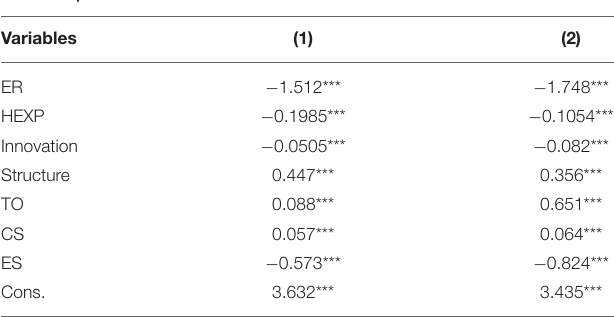
TABLE 7 | Robust results OLS.